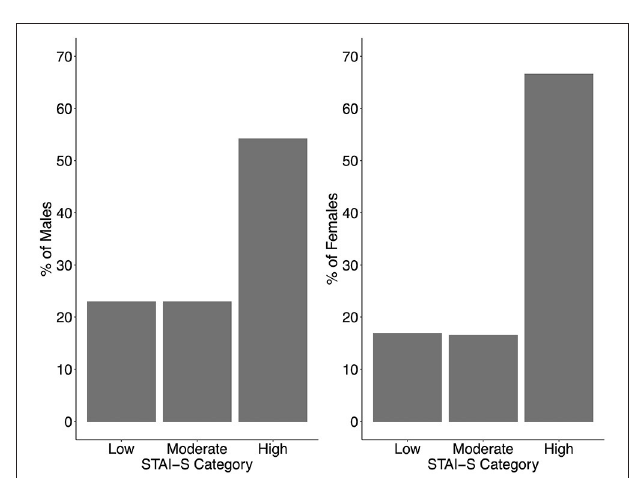
FIGURE 4 | Percentage of males ( n = 144; left panel) and females ( n = 634; right panel) scoring in each category of the State Trait Anxiety Inventory—State subscale. Note: the students with gender other than male or female all scored in the High STAI-S category ( n =